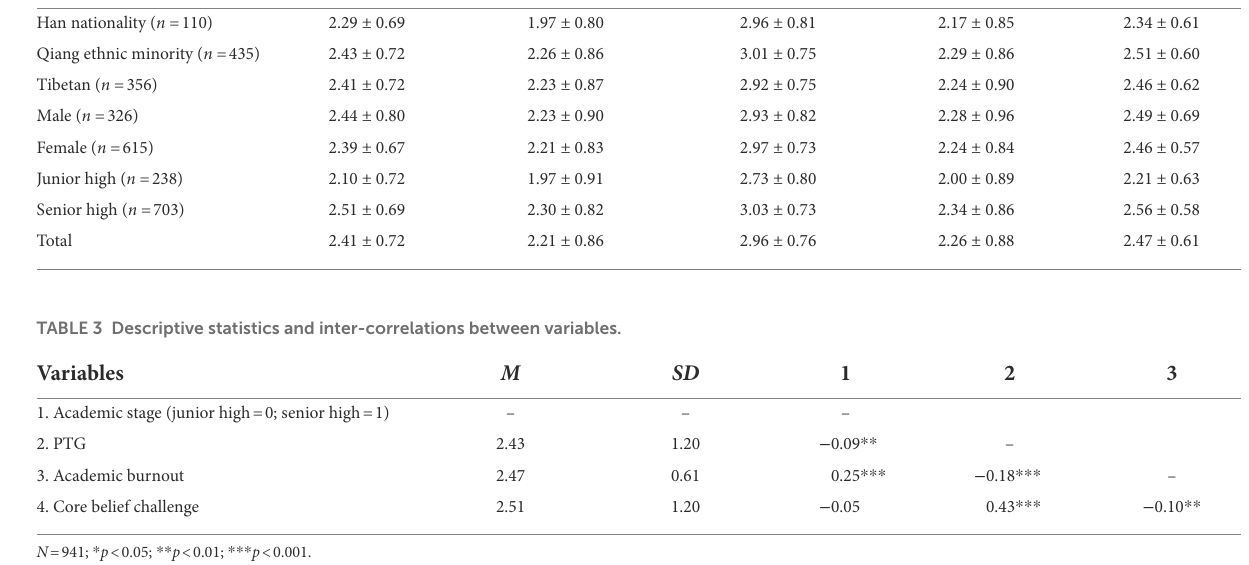
TABLE 4 Moderating effect of the core belief challenge on PTG and academic